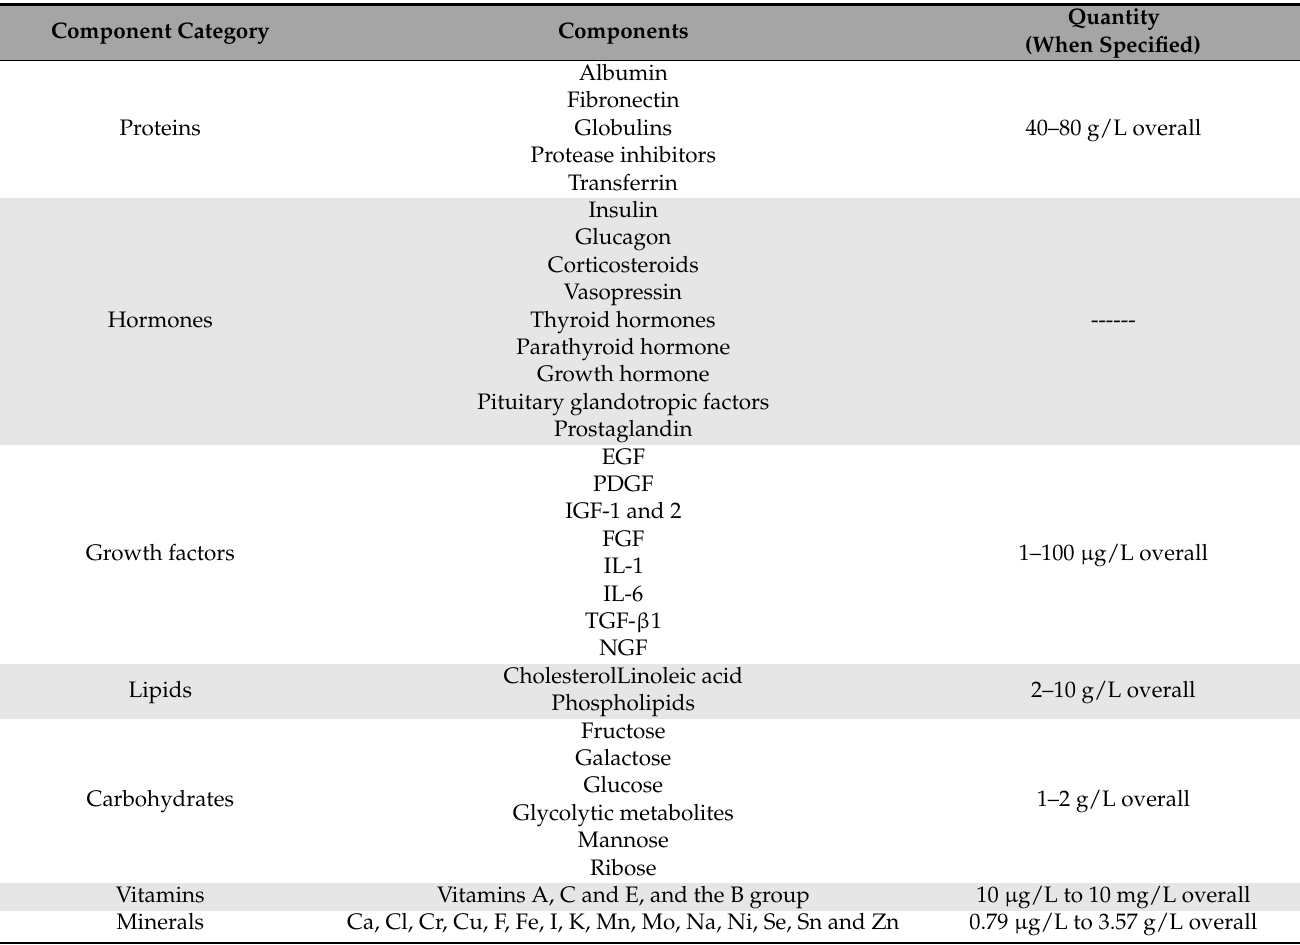
Table 1. Constituents of foetal bovine